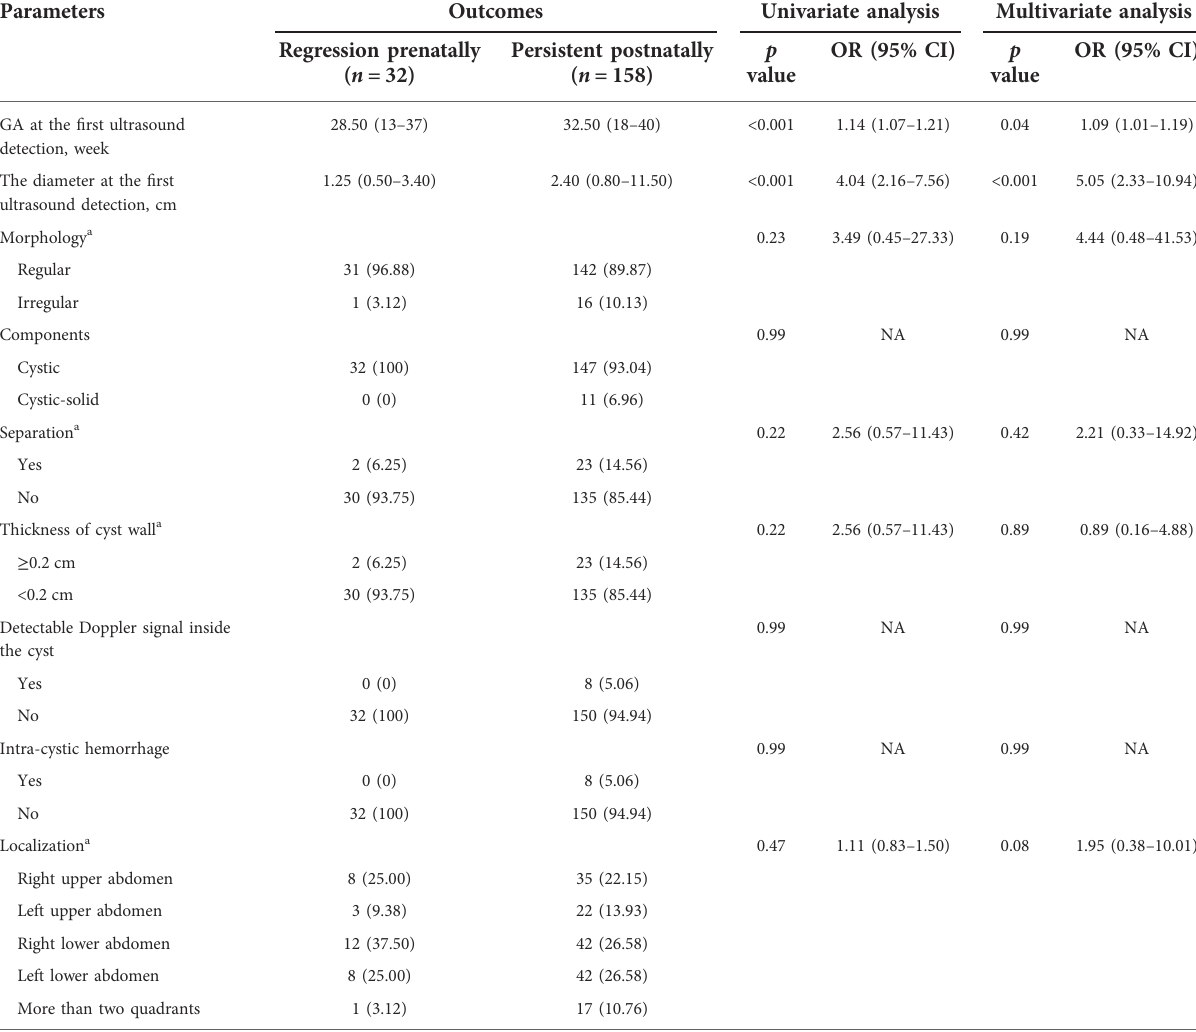
TABLE 3 Univariate analysis and multivariate analysis of possible predictors of spontaneous regression prenatally in 190 fetuses.